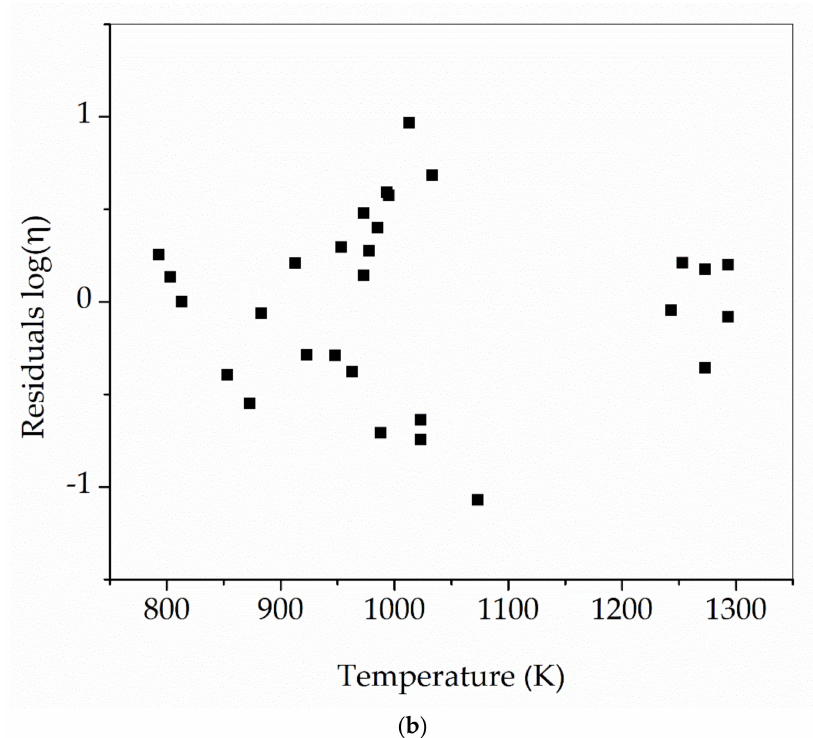
Figure 10. Residuals of the fitted function η = η ( T , τ ). In ( a ), it is found that residuals increase with the decreasing value of τ . In ( b ), no correlation is seen between residuals and temperature. η in Pa s and τ in s.